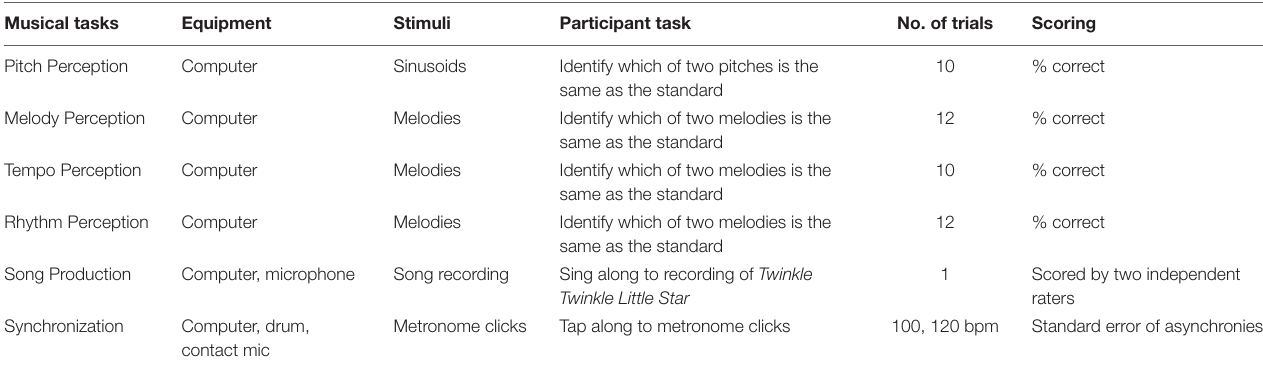
TABLE 1 | Summary of music perception and production tasks. Musical